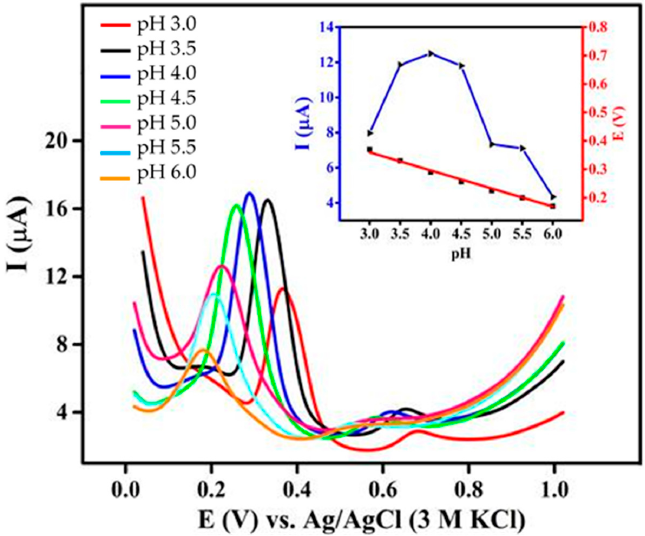
Figure 4. DPVs of 0.1 M phosphate buffer (pH of 3, 3.5, 4, 4.5, 5, 5.5, and 6) containing 30 μ M GA at a scan rate of 0.1 V ∙ s − 1 . Inset: effect of pH on oxidation peak current (blue) and oxidation peak potential (red).